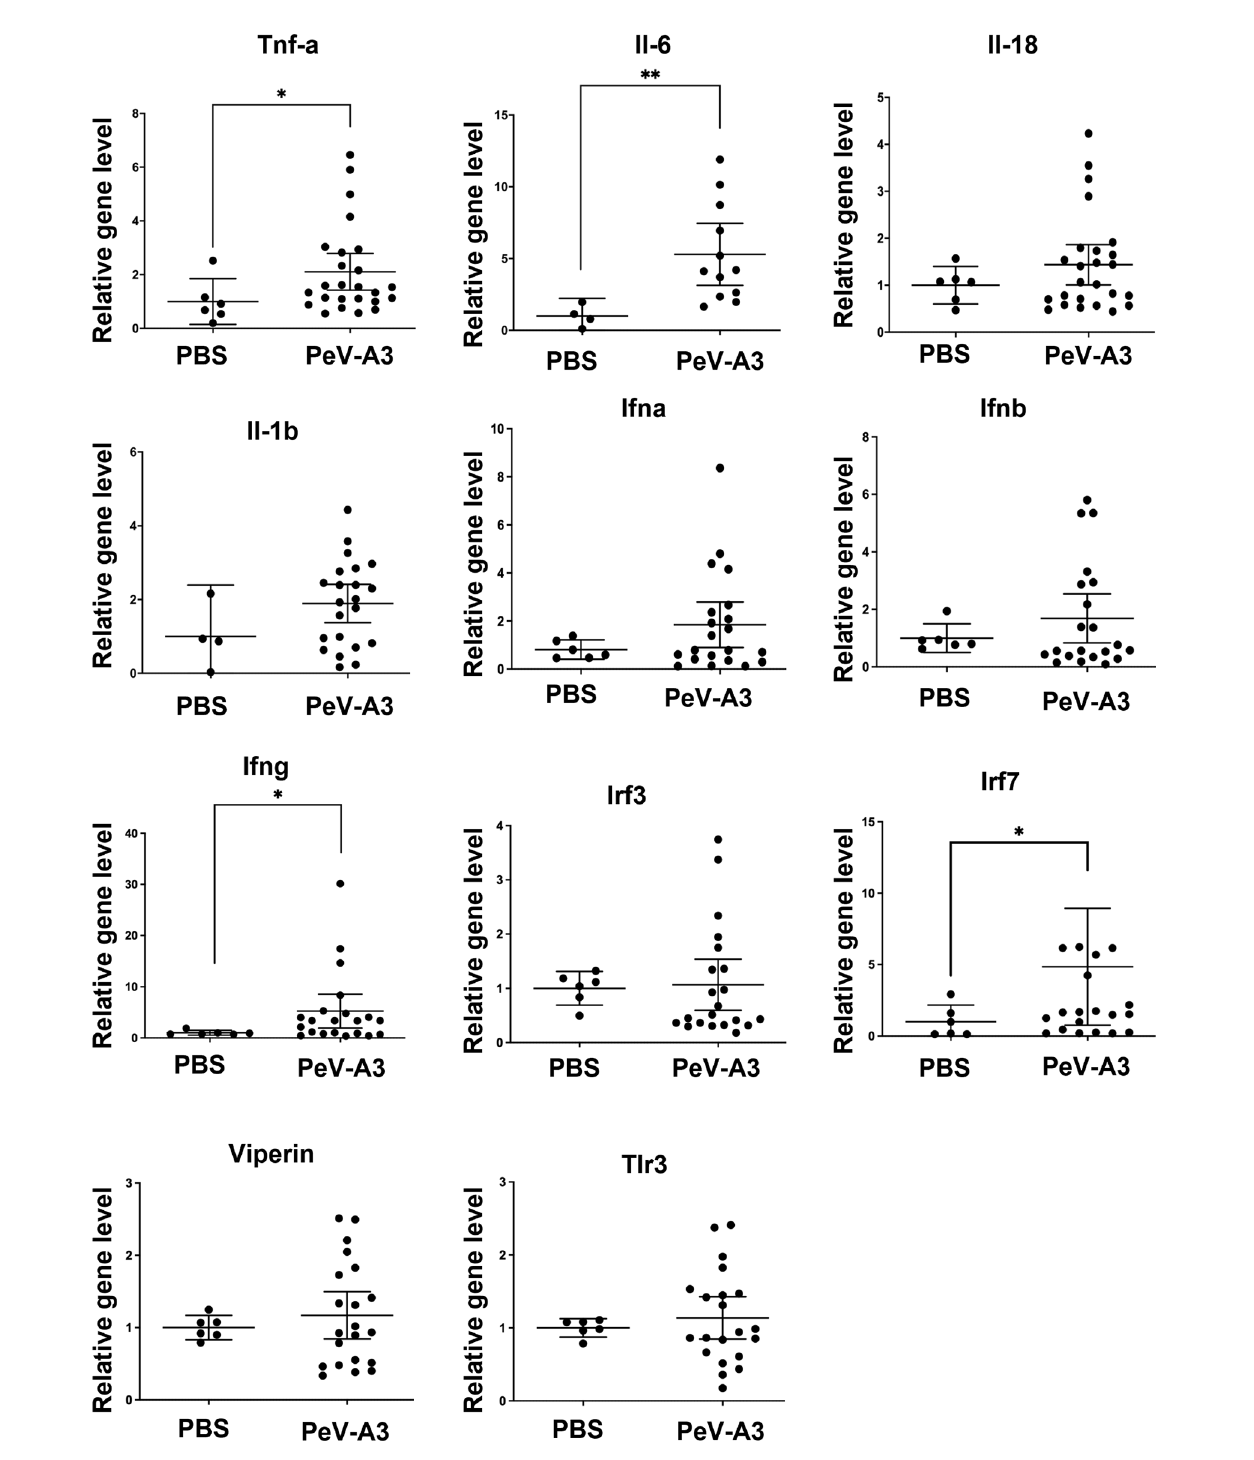
FIGURE 8 | PeV-A3 induced in fl ammatory cytokine expression and signal transduction in mouse brain tissues. mRNA expression of in fl ammatory cytokines (Tnfa, Il- 6, Il-8, and Il-1b) and interferon signature genes (Ifna, Ifnb Ifng Irf3, Irf7, Viprin, and Tlr3) in PeV-A3-infected C57BL/6 mouse brain tissues were measured and normalized using HPRT. Data are mean ± SD, PBS group, N = 4-6, PeV-A3 group, N = 12 – 25. Independent two-sample t-test, * p < 0.05; ** p < 0.01 compared with PBS. PeV-A3, parechovirus type 3; PBS, phosphate-buffered